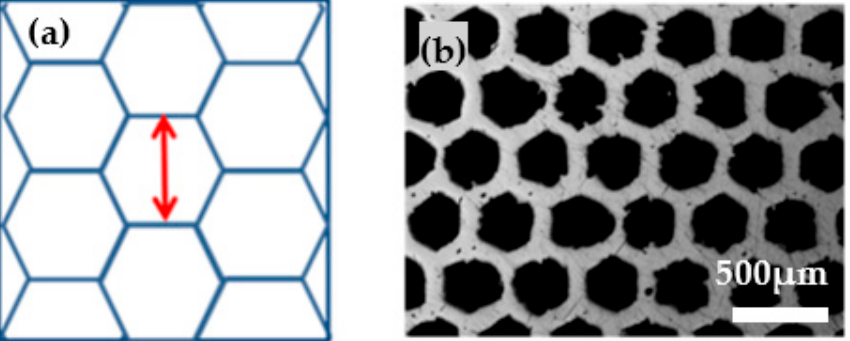
Figure 7. Honeycomb pattern. ( a ) Blue lines depict line scan of the laser, red arrows correspond to the applied hatch distance. ( b ) Microscopic picture of an exemplary honeycomb pattern.